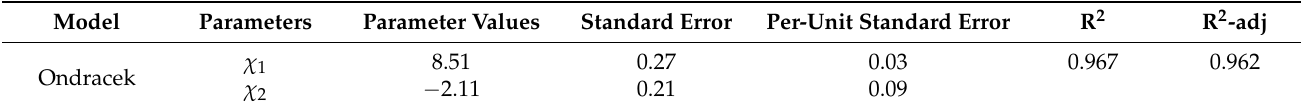
Figure 4. Comparing the Dalmas s-shape model (DsM) with experimental measurement.